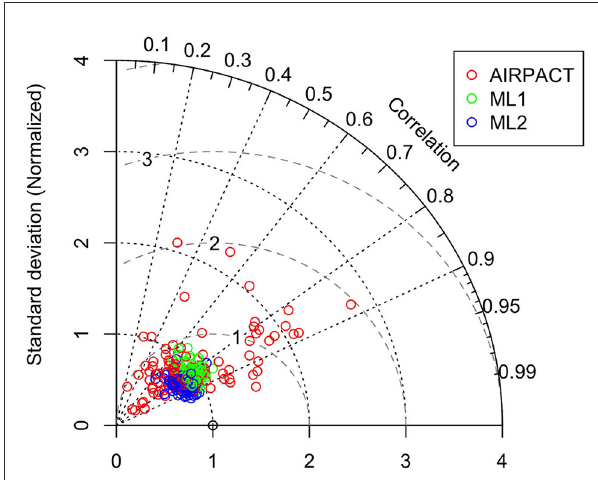
FIGURE9 Taylor diagram of wildfire season daily PM2.5. Each circle symbol represents an AQS site, and the red color is for AIRPACT, green for ML1, and blue for ML2. Note that centered RMS difference is proportional to the distance from the point on the x-axis (standard deviation) marked with an open